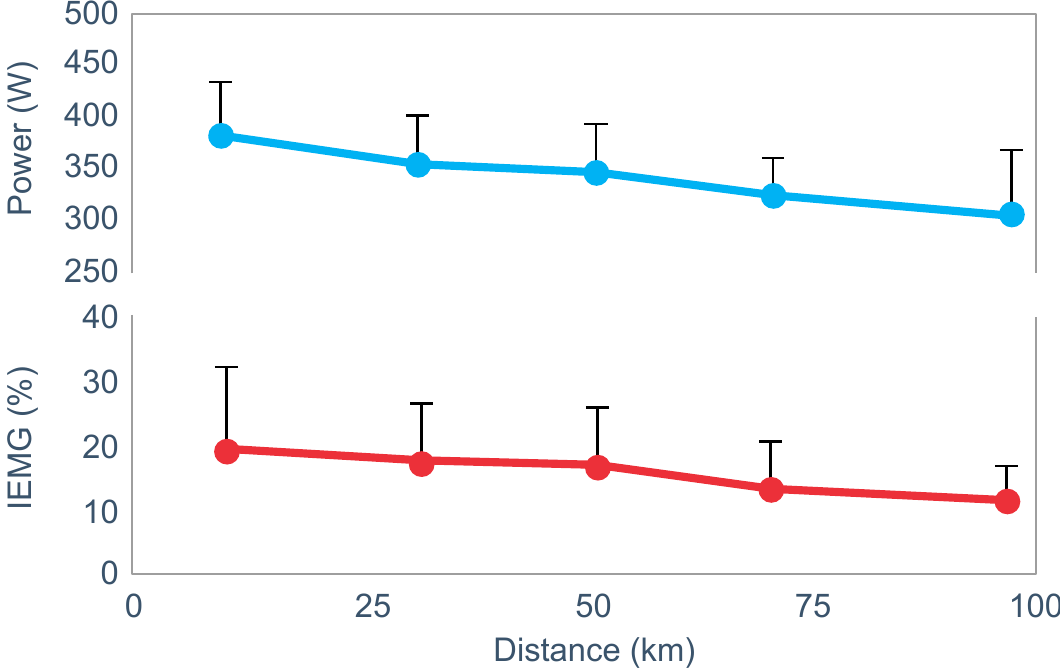
Figure 18. Equivalent and progressive reductions in power output and electromyographic activity in the exercising leg muscles during five 1 km sprint during a 100 km cycling time trial in the laboratory. This indicates the presence of a centrally-regulated homeostatic control that progressively reduces motor unit recruitment in the exercising limbs during prolonged exercise. This shows that performance is ‘regulated’, not ‘limited’ during exercise [11]. Adapted with permission from ref. [110]. Copy-right 2001 American Physiological